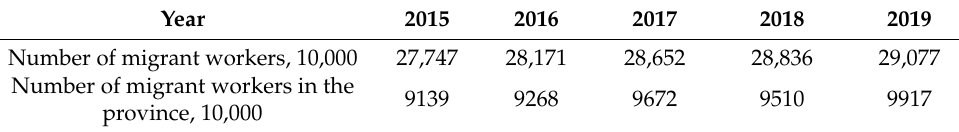
Table 6. Number of migrant workers in China during